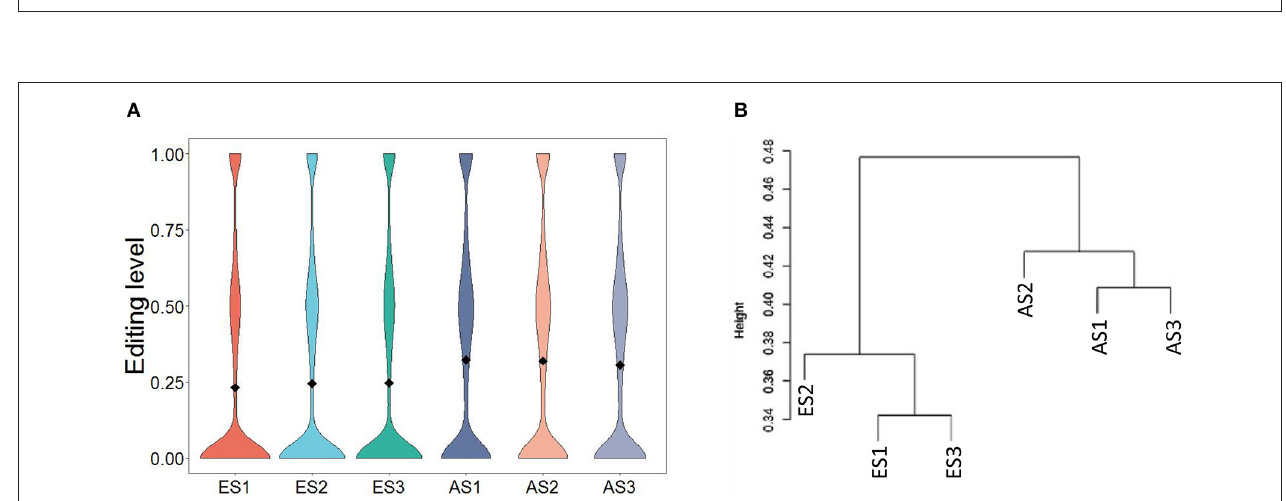
FIGURE 3 | Statistical features of the RNA editing sites that changed miRNA binding capacity.